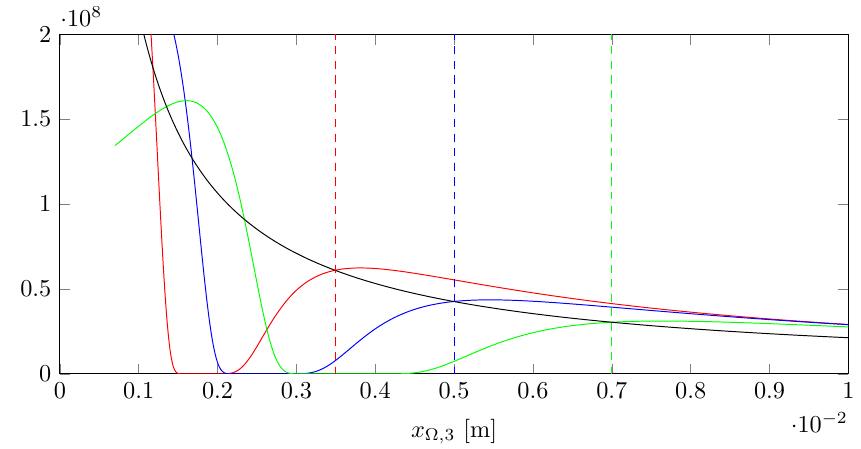
Figure 3. The near-field for different positions of the focus (red, blue, green) vs. the far-field (black) regime for different positions of the surface. At the dotted lines, indicating where the surface and focus position coincide, the intensities of near- and far-field regime are